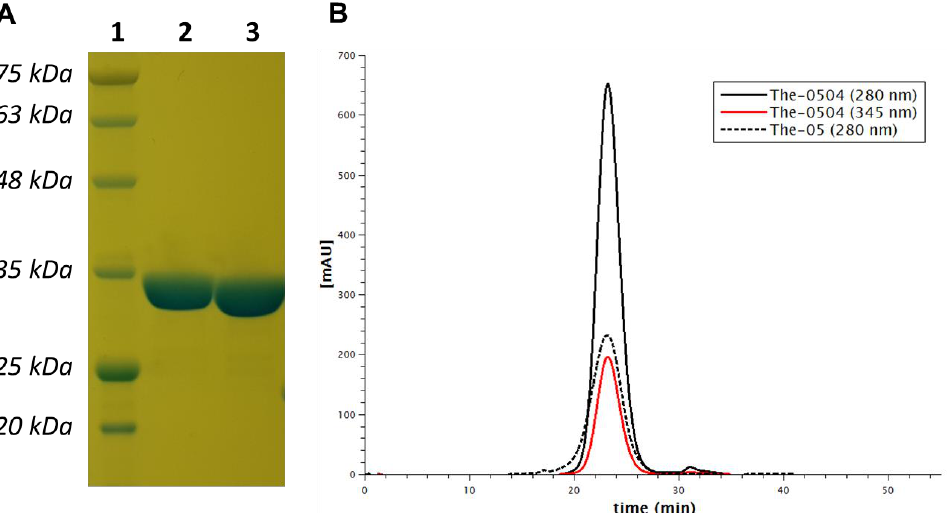
Figure 2. Purity of the The-05 nanocarrier before and after Genz-644282 encapsulation. ( A ) SDS-PAGE band migration profiles: Lane 1, protein marker; Lane 2, The-05 (10 µg); Lane 3, The-0504 (10 µg). ( B ) Size-exclusion chromatography analysis of The-05 and The-0504 detecting simultaneously The-05 protein and Genz-644282 contributions at 280 nm (black) and 345 nm (red), respectively.